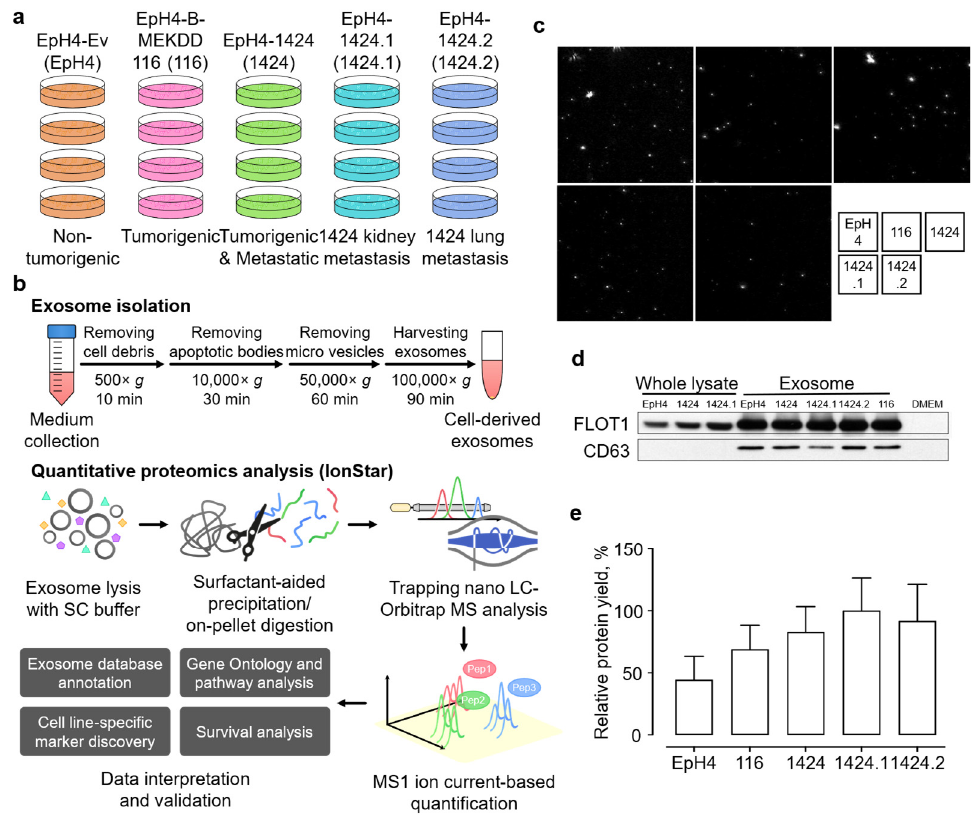
Figure 1. Quantitative proteomics investigation of exosomes isolated from primary and derived EpH4-Ev cell lines with different tumorigenic and metastatic capabilities. ( a ) Specification of samples in this study; ( b ) the scheme for exosome sample preparation and proteomic experimental procedures; ( c ) images of exosomes isolated from the five cell lines; ( d ) Western blot assay of exosome markers FLOT1 and CD63 in whole-cell lysate and isolated exosome samples; ( e ) relative protein yield from exosome samples among the five cell lines.